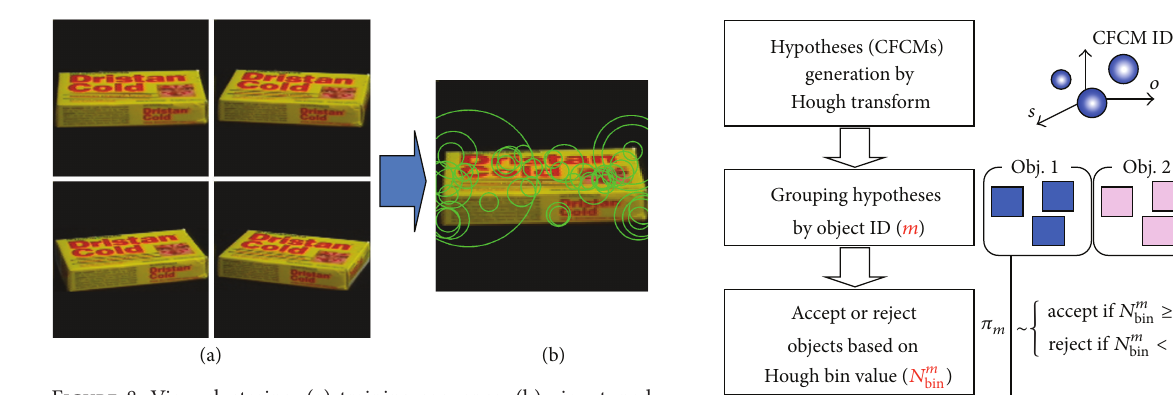
Figure 8: View clustering: (a) training sequence; (b) view-tuned CFCM.